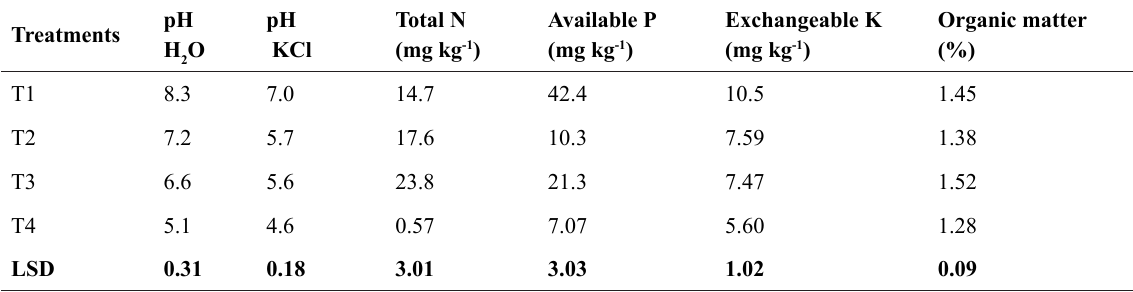
T1, 30 t ha -1 Poultry manure; T2, 30 t ha -1 Cow manure; T3, 30 t ha -1 Pig manure; T4, Control, without manure application, LSD, Least